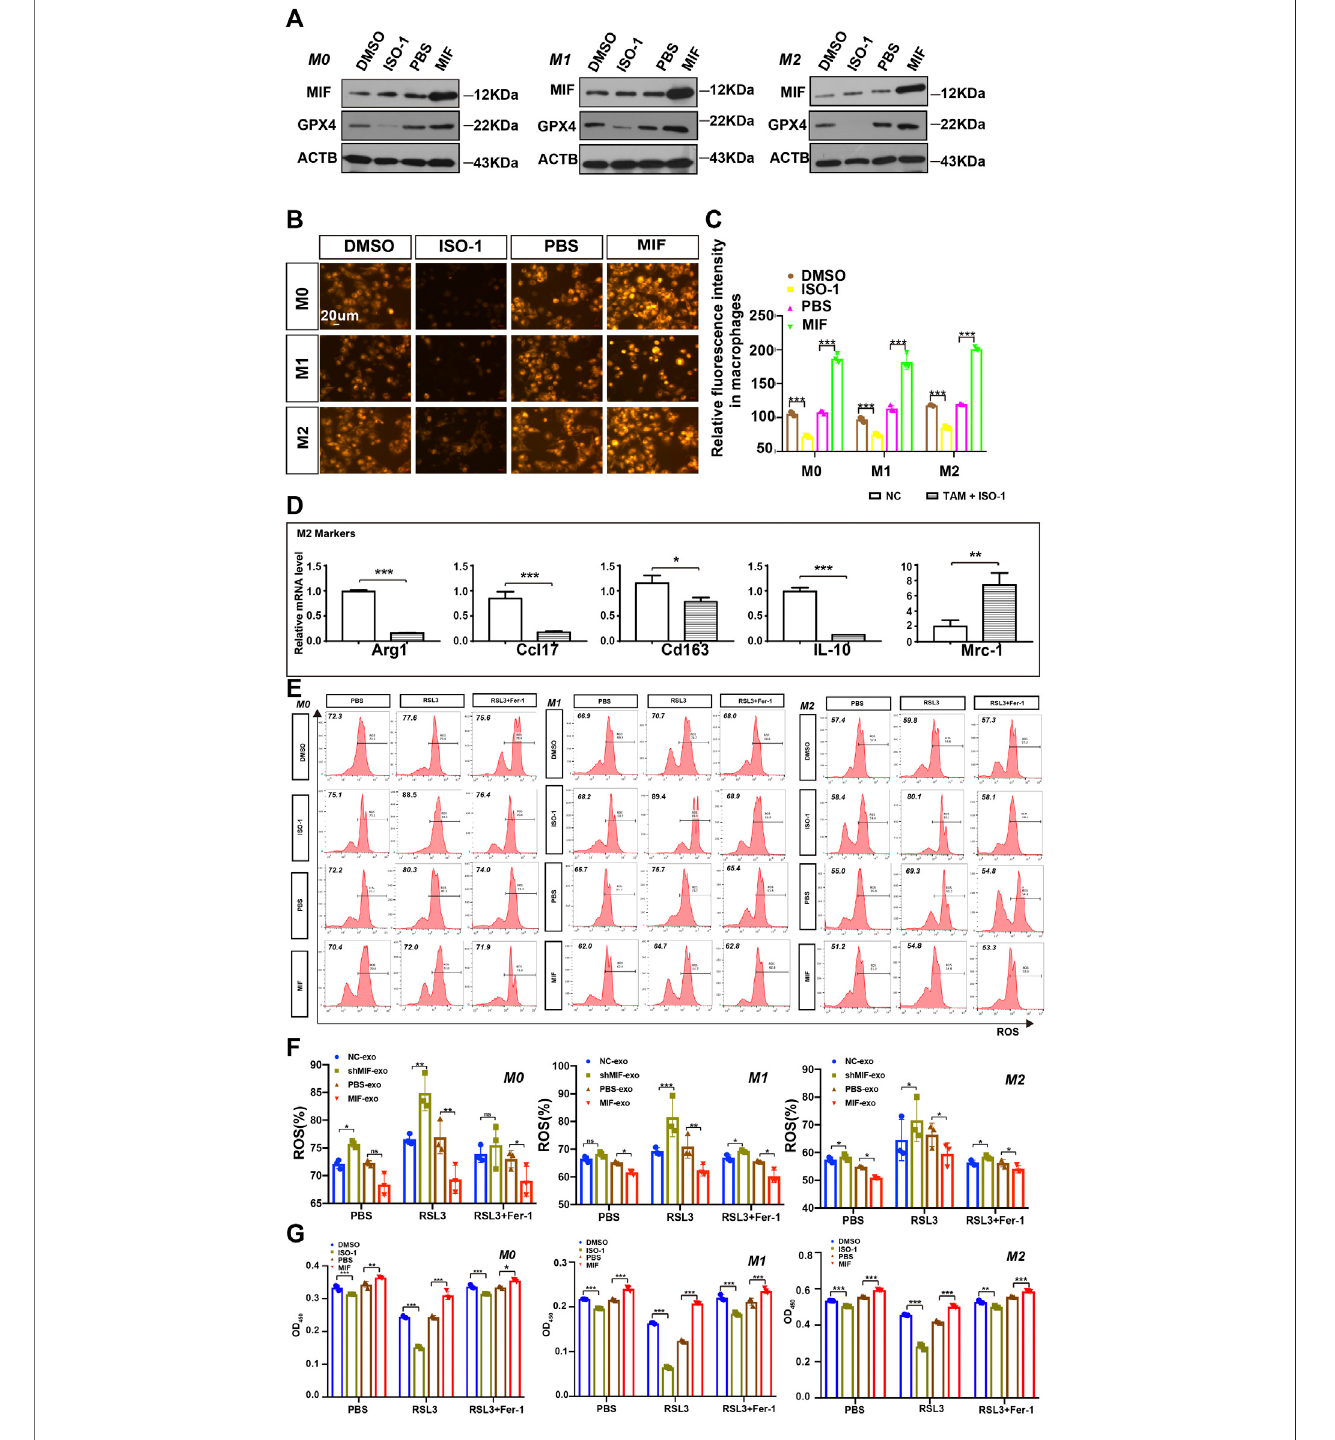
FIGURE 4 | MIF inhibits ferroptosis of macrophages in vitro . (A) WB analysis of the relationship between GPX4 and MIF expression levels in M0, M1 and M2 macrophages. (B) FerroOrange experiment involving staining of divalent iron in macrophages. Scale bar:20 um. (C) Statistical analysis of the fl uorescence intensity of ferrousiron. (D) AfterISO-1wasadded,macrophagepolarizationwasdetected byqRT-PCR. (E,F) FlowcytometryofROSinmacrophages(Two-wayANOVA). (G) Cell death was estimated by CCK8 assay (Two-way ANOVA). All graphs show the mean ± SEM of at least three independentexperiments. * p < 0.05, ** p < 0.01, *** p < 0.001.